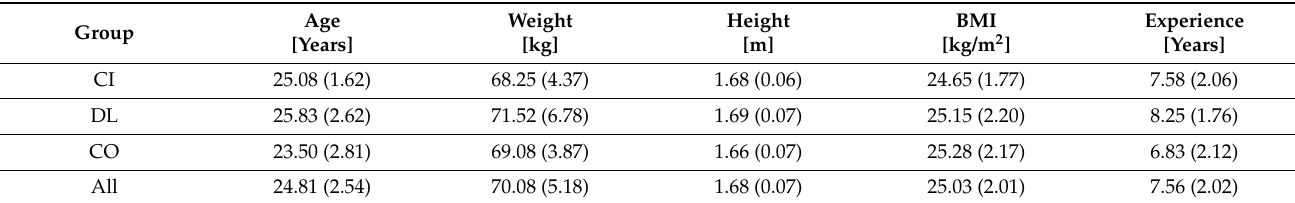
Table 2. Group specific personal data (averages (standard deviations)) of